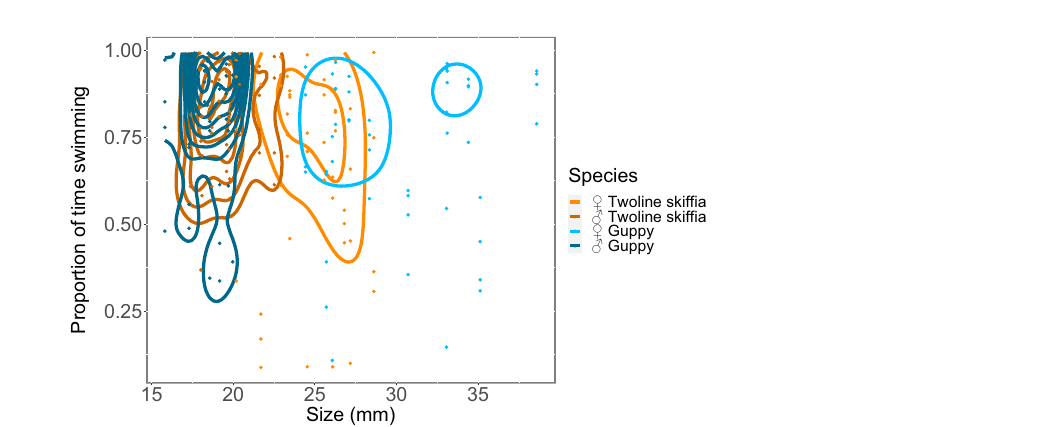
Figure 3. Proportion of the total time observed (600 s) fish of different sizes spent exploring the rock. Lines represent the areas where the density of data is higher.